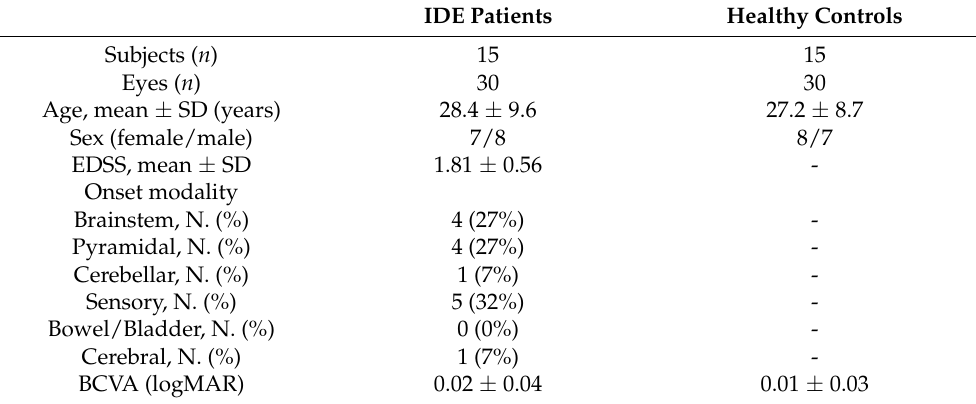
Table 1. Demographic and clinical characteristics of patients with IDE and healthy controls.